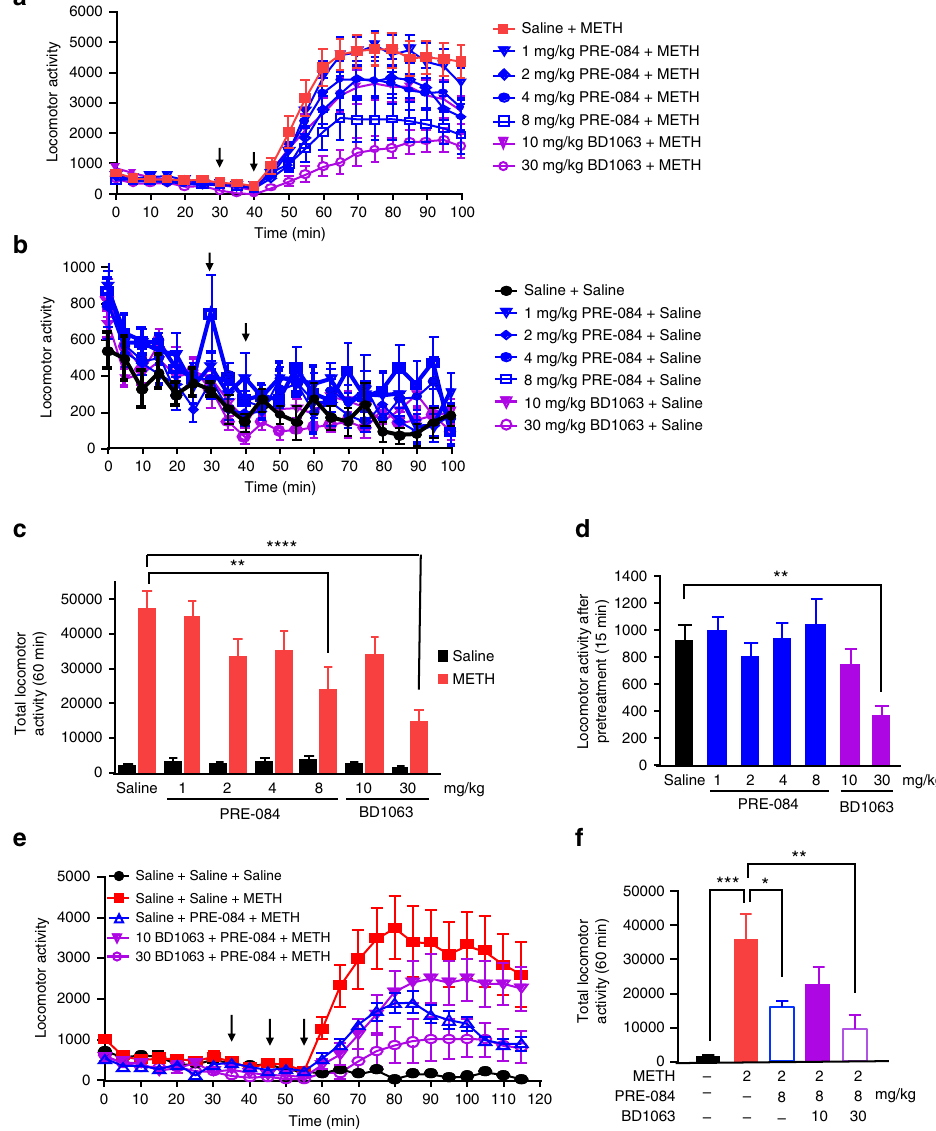
Fig. 5 σ 1 R activation decreases acute METH-mediated behavioral responses. After 30-min habituation to the locomotor chamber, C57BL/6 mice were pretreated with either saline, 1 – 8 mg/kg PRE-084, or 10 or 30 mg/kg BD1063 by i.p. injection followed by treatment with ( a ) 2 mg/kg METH or ( b ) saline after 15 min. Locomotor activity was detected via automated locomotor chambers during the habituation, pretreatment, and 60 min after saline or METH treatment at 5 min bins. c Graph shows the total locomotor activity after the second injection (METH or saline). Whereas METH alone increased locomotion, 8 mg/kg PRE-084 and 30 mg/kg BD-1063 both decreased METH-stimulation of locomotion, while all other doses tested had no effect on baseline or METH-stimulated locomotion. ( n = 8 mice for METH treatment, 6 mice for saline treatment, F (6,86) = 3.418, P = 0.0045 two-way ANOVA, Sidak ’ s multiple comparisons within saline or METH, *** P = 0.0007 and **** P < 0.0001). d Locomotor activity measured during the 15 min after pretreatment but prior to METH treatment in experiments performed in Fig. 5a and b revealed 30 mg/kg BD1063 acutely decreased locomotor activity in the rodents. ( n = 8 mice for all groups, F (6,93) = 3.356, P = 0.0049, one-way ANOVA; Dunnett ’ s test for multiple comparisons against saline, ** P = 0.0095). e C57BL/6 mice were pretreated with either saline or 10 or 30 mg/kg BD1063 by i.p. injection followed by treatment with saline or 8 mg/kg PRE-084 after 15 min. Mice then received a third injection of either saline or 2 mg/kg METH after 15 min and locomotor activity was measured for 60 min. f While 10 mg/kg BD1063 modestly blocked of the effect of PRE-084 on reducing METH-stimulated locomotor activity over time, treatment with 30 mg/kg BD1063, similar to Fig. 5a and c, resulted in a signi fi cant decrease in METH-induced locomotor activity ( F (4,35) = 4.247, P = 0.0002, one-way ANOVA; Tukey ’ s test for multiple comparisons, *** P = 0.001, * P < 0.02, ** P = 0.0034). Data is represented as mean ± internalization measured as a decrease in the YFP-DAT fl uores- stimulated cell surface redistribution of DAT (Supplementary cence signal in the TIRF fi eld (Supplementary Fig. 4c and d). Fig. 4b). Considering the possibility that σ 1 R activation accel- PRE-084 pretreatment did not alter vehicle or METH-induced erates the rate of DAT traf fi cking beyond detection by the bio- cell surface redistribution of DAT at any time points, con fi rming tinylation assay, we used live cell total internal re fl ection surface biotinylation data and suggesting that PRE-084 activation microscopy (TIRFM) to measure time-dependent DAT traf fi ck- of σ 1 R does not increase or decrease basal DAT traf fi cking or ing. Consistent with previous reports 51,52 , METH-induced DAT